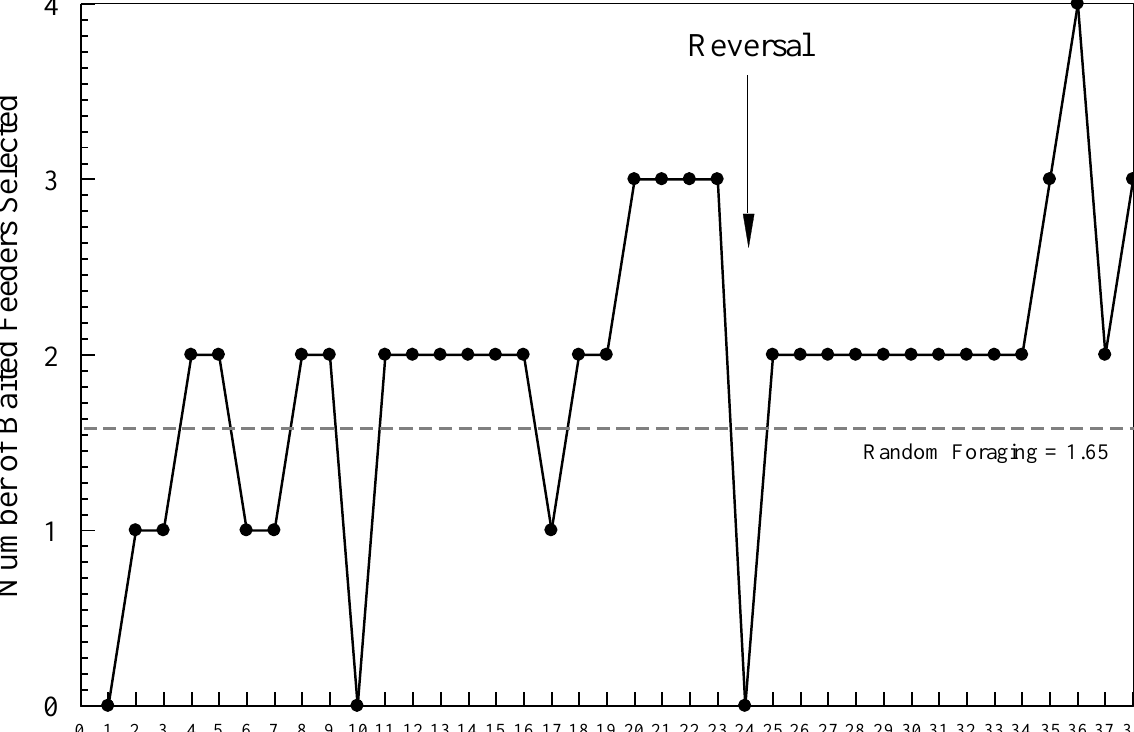
Figure 1. Male A success in first four selections Reversal